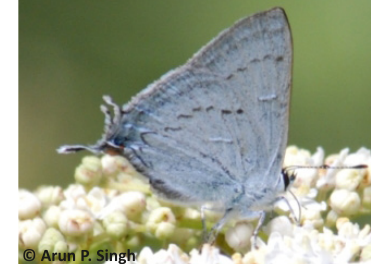
Image 3. Straightwing Blue Orthomiella pontis pontis Elwes